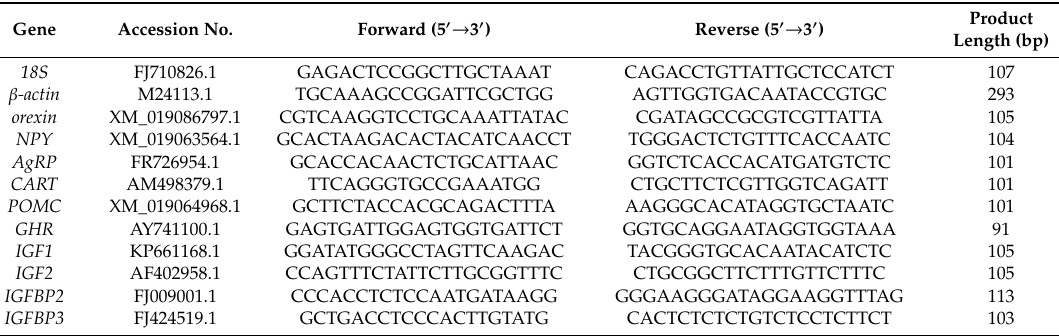
Table 2. Primers used in qRT-PCR